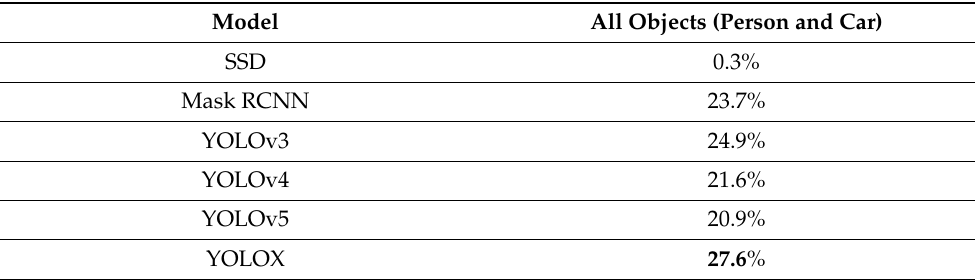
Table 3. Comparative results of different models for the person and car classes detection on a dataset of color images. Results are presented with Average Precision (AP) 0.5:0.95 using COCO_eval